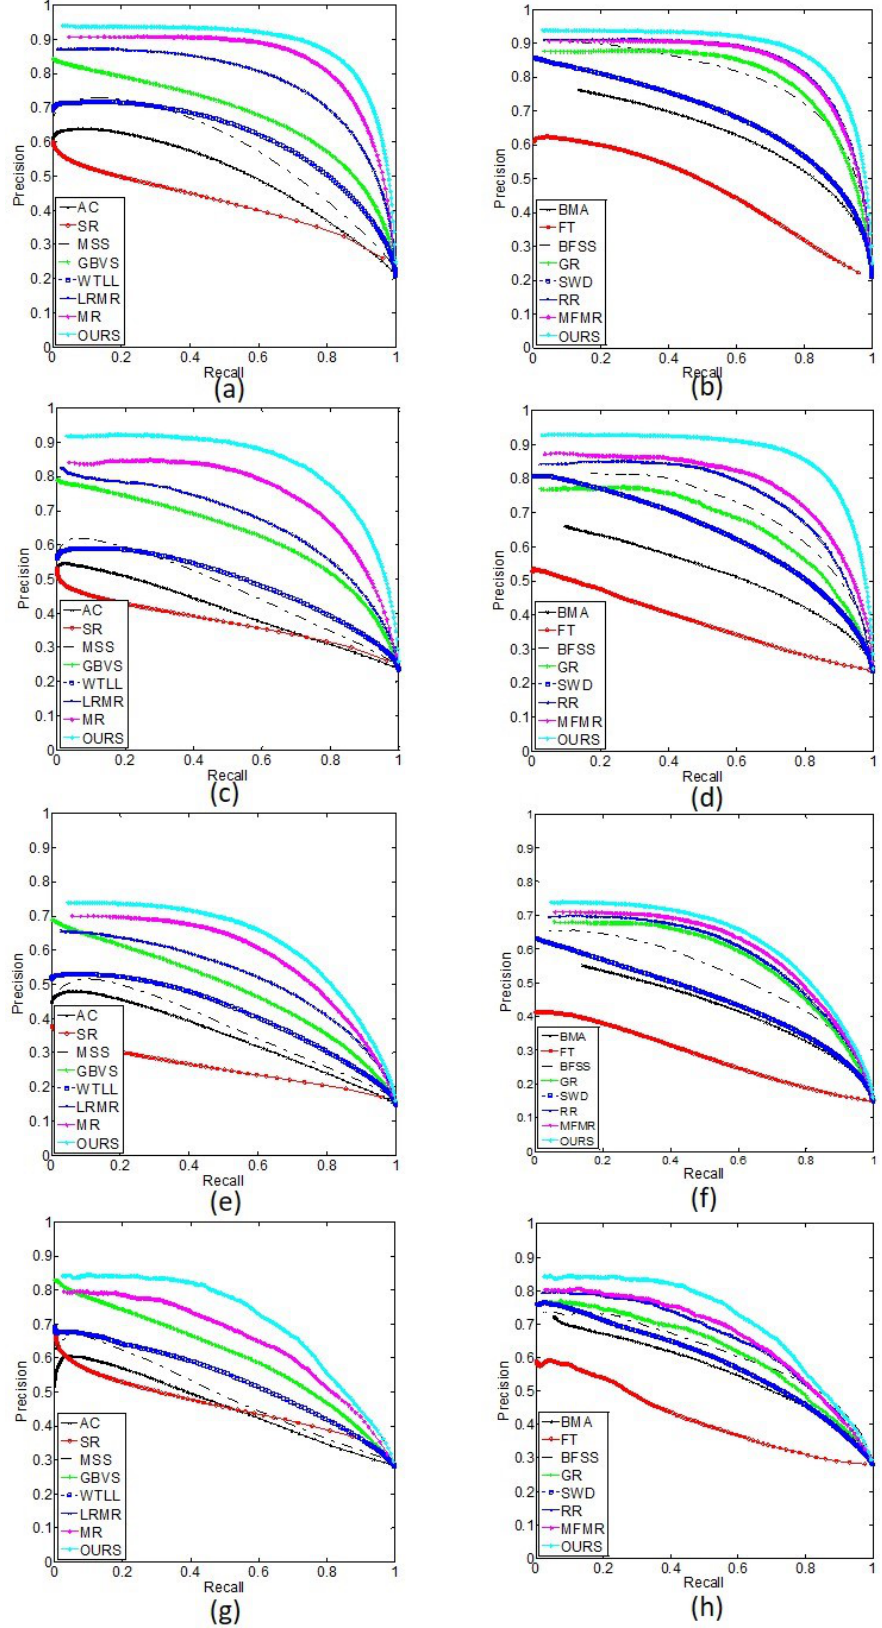
Figure 5. The PR curves of different methods on four datasets: ( a , b ) MSRA-5000 dataset; ( c , d ) ECSSD dataset; ( e , f ) DUT-OMRON dataset; ( g , h ) SOD